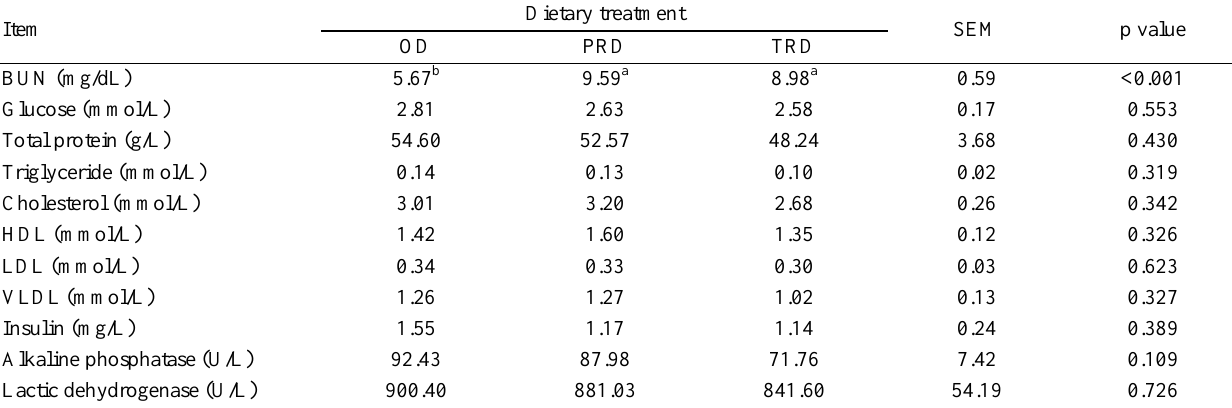
Table 4. Effects of partial or total replacement of maize with alternative feed sources on blood metabolites Item